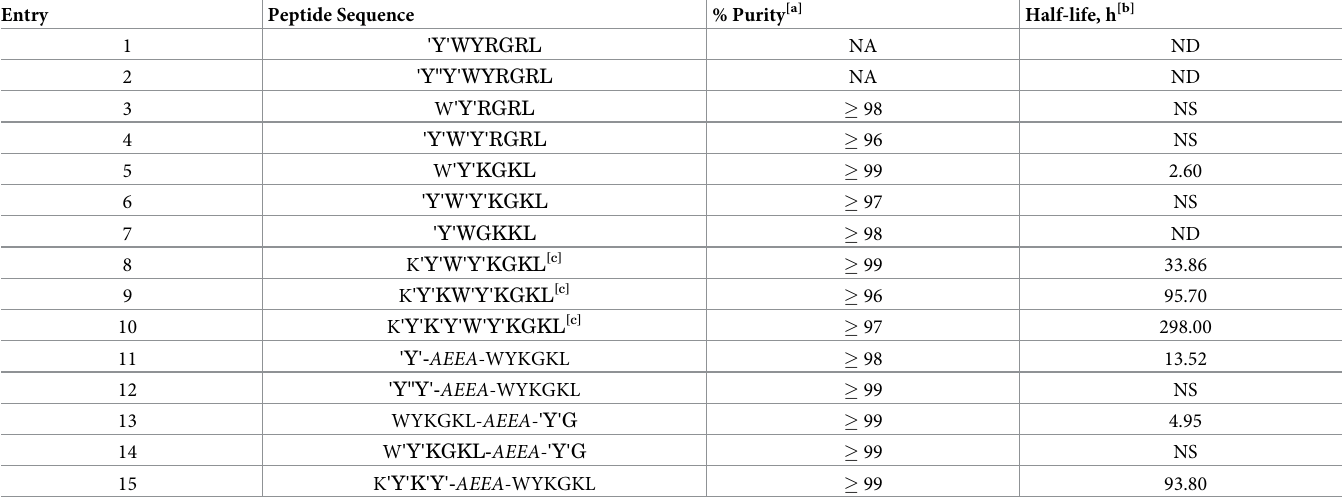
Table 1. Percentage purities of synthesised DIT peptides and their ex vivo binding half-lives to the cartilage of murine